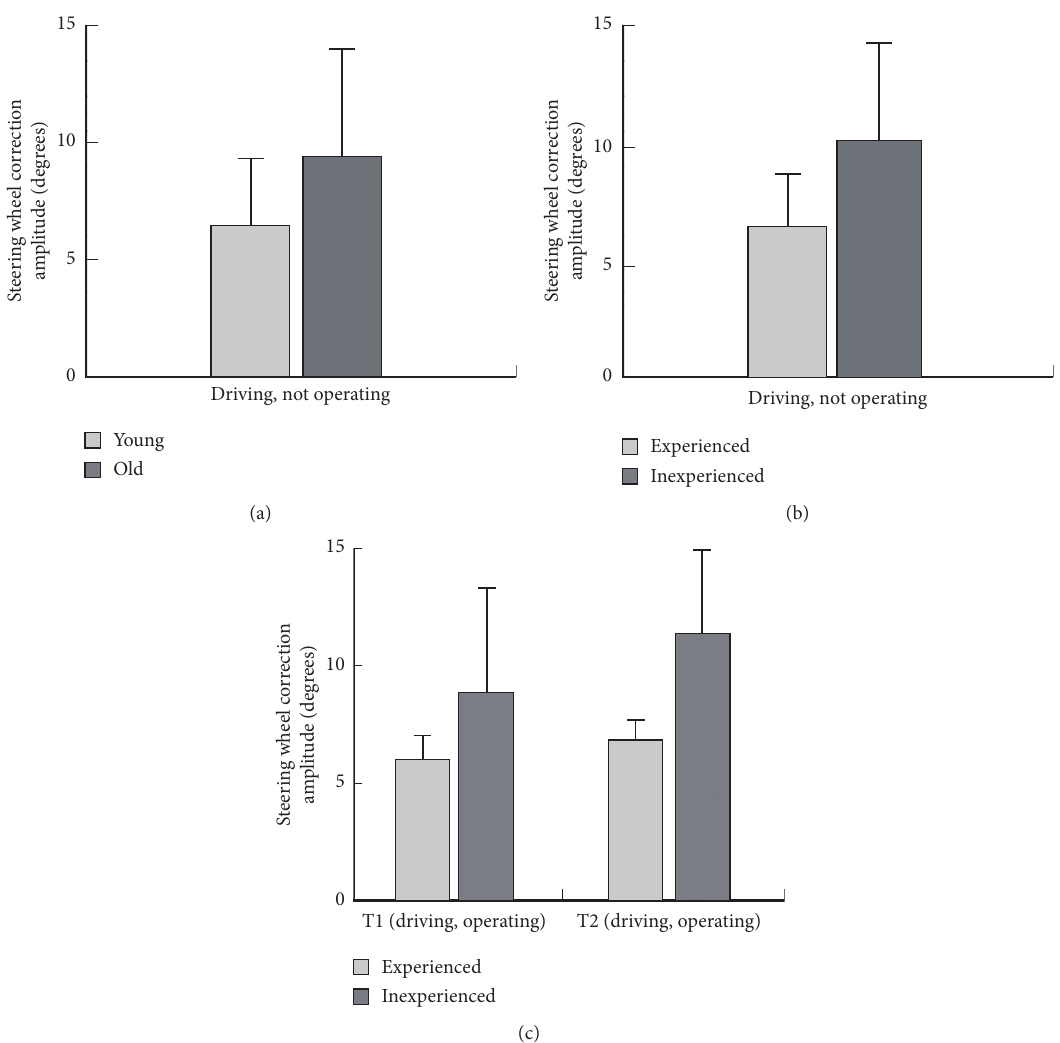
Figure 6: Steering wheel correction amplitude. The steering wheel correction amplitude of (a) different ages and (b) different experience levels. (c) The steering wheel correction amplitude of experienced and inexperienced drivers while driving and using car-sharing software. Table 6: Descriptive statistics of frequency and percentage of driving error among different ages and experience levels. Frequency 0.00 5.00 z P Without operating car-sharing software